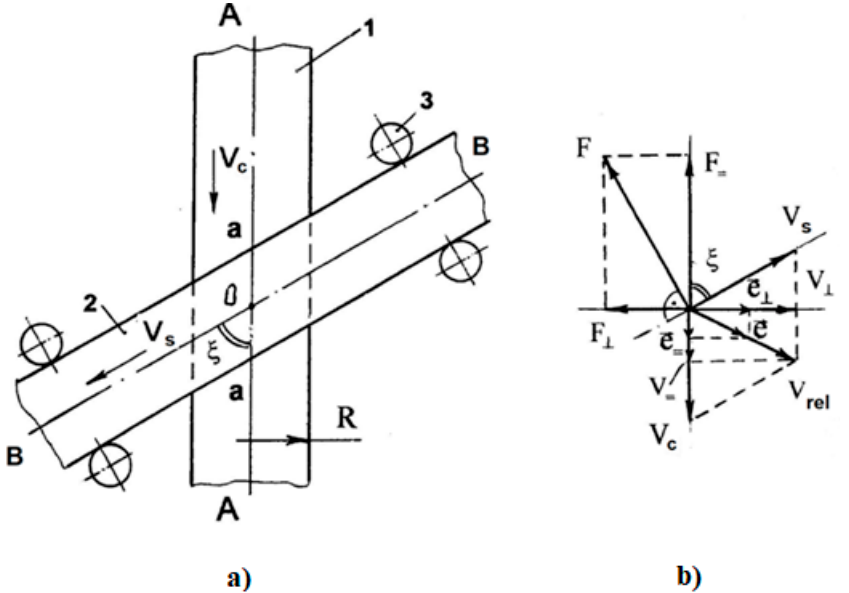
Figure 6. Calculation scheme of device for estimation of friction anisotropy on cylindrical surface ( a ) The design scheme of the device (Figure 7) and ( b ) the scheme of the application of forces.